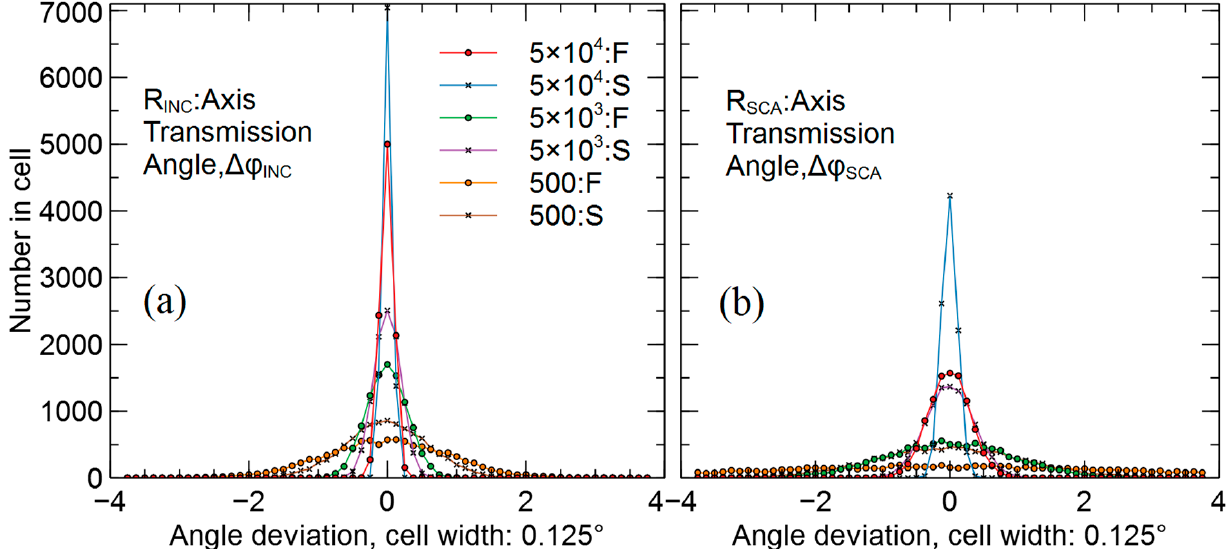
  Δ ( a ) and ϕ Δ ( b ) of > > ϕ ϕ ( a ) and ∆ ( b ) of SCA INC SCA